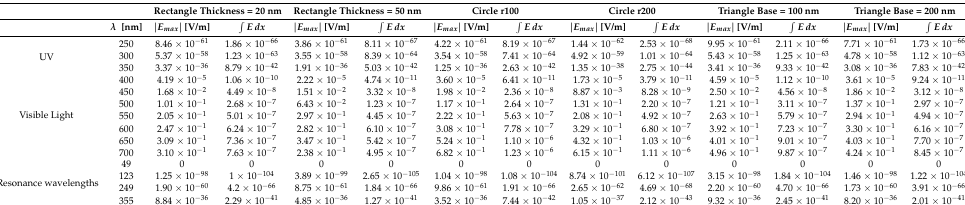
Table A3. Summary table of the results obtained for the silver nanostructures—Probe 3.